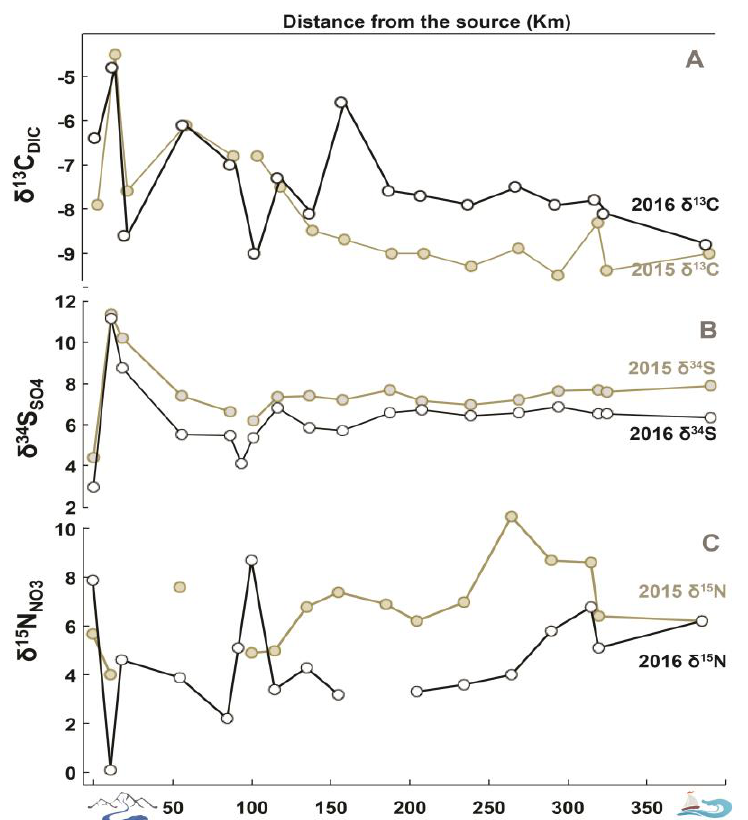
Figure 3. Spatial variations in the ( A ) δ 13 C DIC , ( B ) δ 34 S SO4 , ( C ) δ 15 N NO3 of Adige river water collected in May 2015 and August 2016.